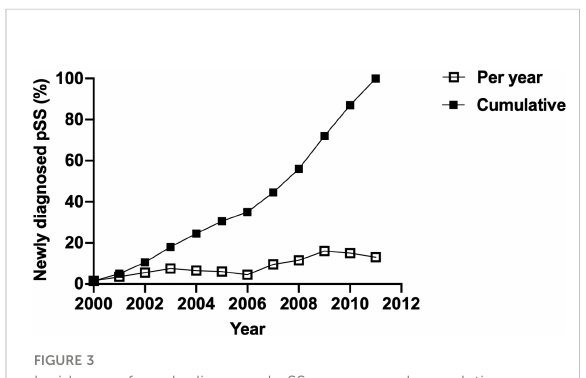
FIGURE 3 Incidence of newly diagnosed pSS per year and cumulative incidence of newly diagnosed